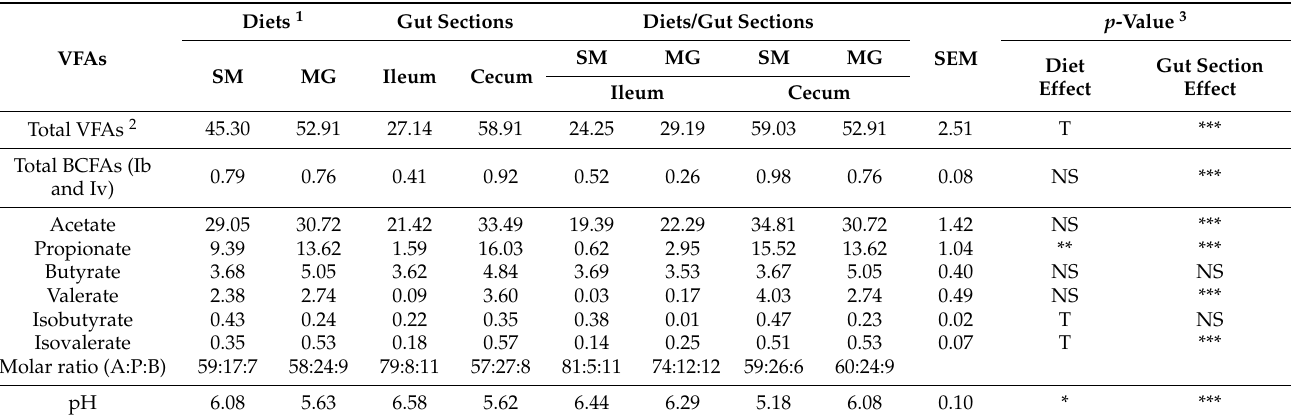
1 Data for each VFA were pooled over both gut sections in order to determine the diet effect as the main factor. There was a standard level of fiber in the SM group and a higher level of fiber than the animal requirement in the